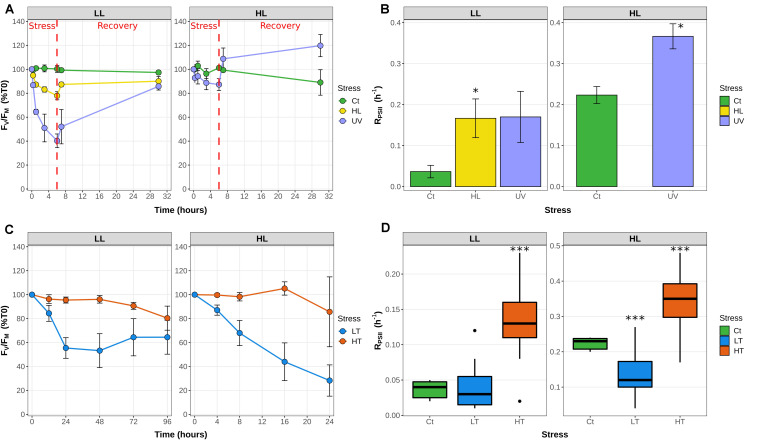
Variation of the photophysiological parameters in response to changes in light or thermal conditions in Synechococcus sp. WH7803 acclimated to low or high light. (A,C) PSII maximal photochemical yield (FV/FM) expressed as % of initial FV/FM after a shift (A) to high light or UV radiations and (C) to low temperature (LT: shift from 22°C to 13°C) or high temperature (HT; shift from 22 to 30°C). The dashed line indicates the time (6 h) at which cultures submitted to light stresses were shifted back to their initial light conditions for recovery. (B,D) Cumulative photosystem II repair rate (RPSII), (B) during the 6 h of light stress and (D) during 1 h for low and high temperature shifts. While for panels (A–C), data represent averages and standard deviations of three biological replicates, for (D), boxplots represent distribution of all three independent measurements, with their medians and interquartiles. Asterisks in (B,D) indicate significantly different values between treatment and control conditions (Student’s t-test) with a single asterisk indicating p < 0.05, double asterisks indicating p < 0.01 and triple asterisks indicating p < 0.001. The top gray banners indicate the culture acclimation condition. These data are based on at least three independent experiments. Ct, control; LL, low light; HL, high light; UV, ultraviolet; LT, low temperature; HT, high temperature.